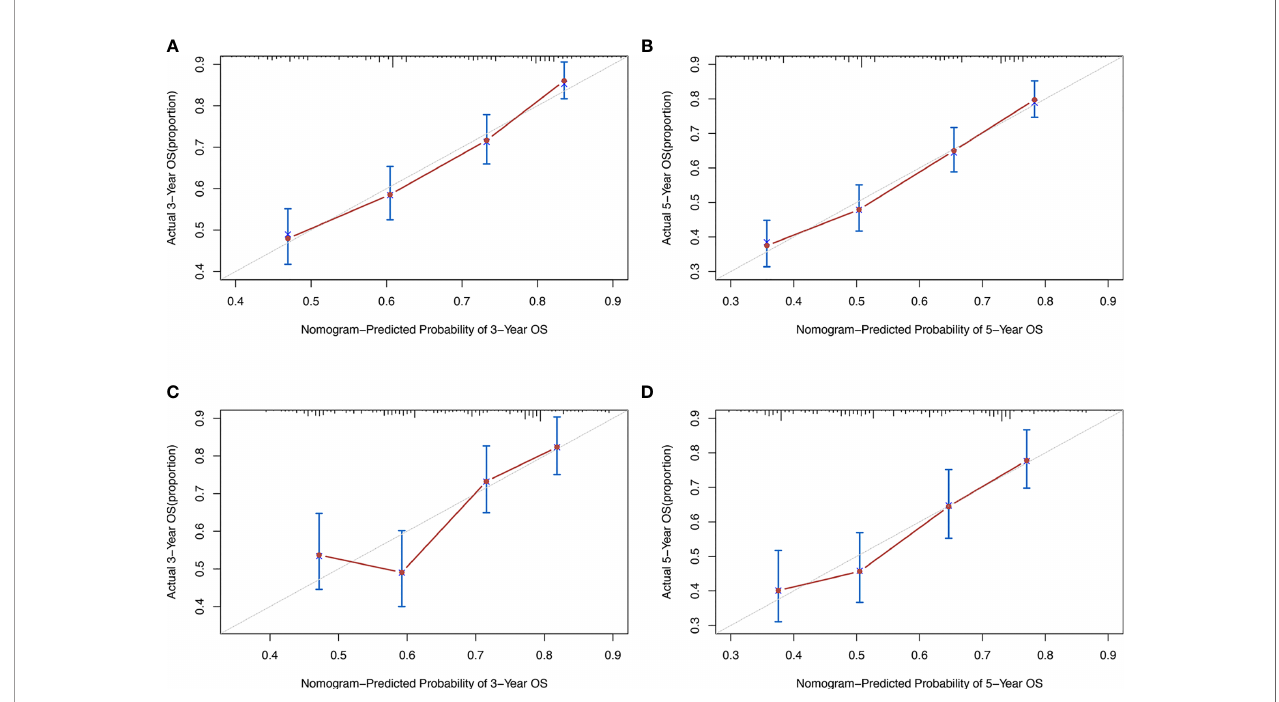
FIGURE 4 | Calibration plot of the prognostic nomogram for each cohort. (A) 3-year calibration plot of the development set. (B) 5-year calibration plot of the development set; (C) 3-year calibration plot of the validation set; (D) . 5-year calibration plot of the validation